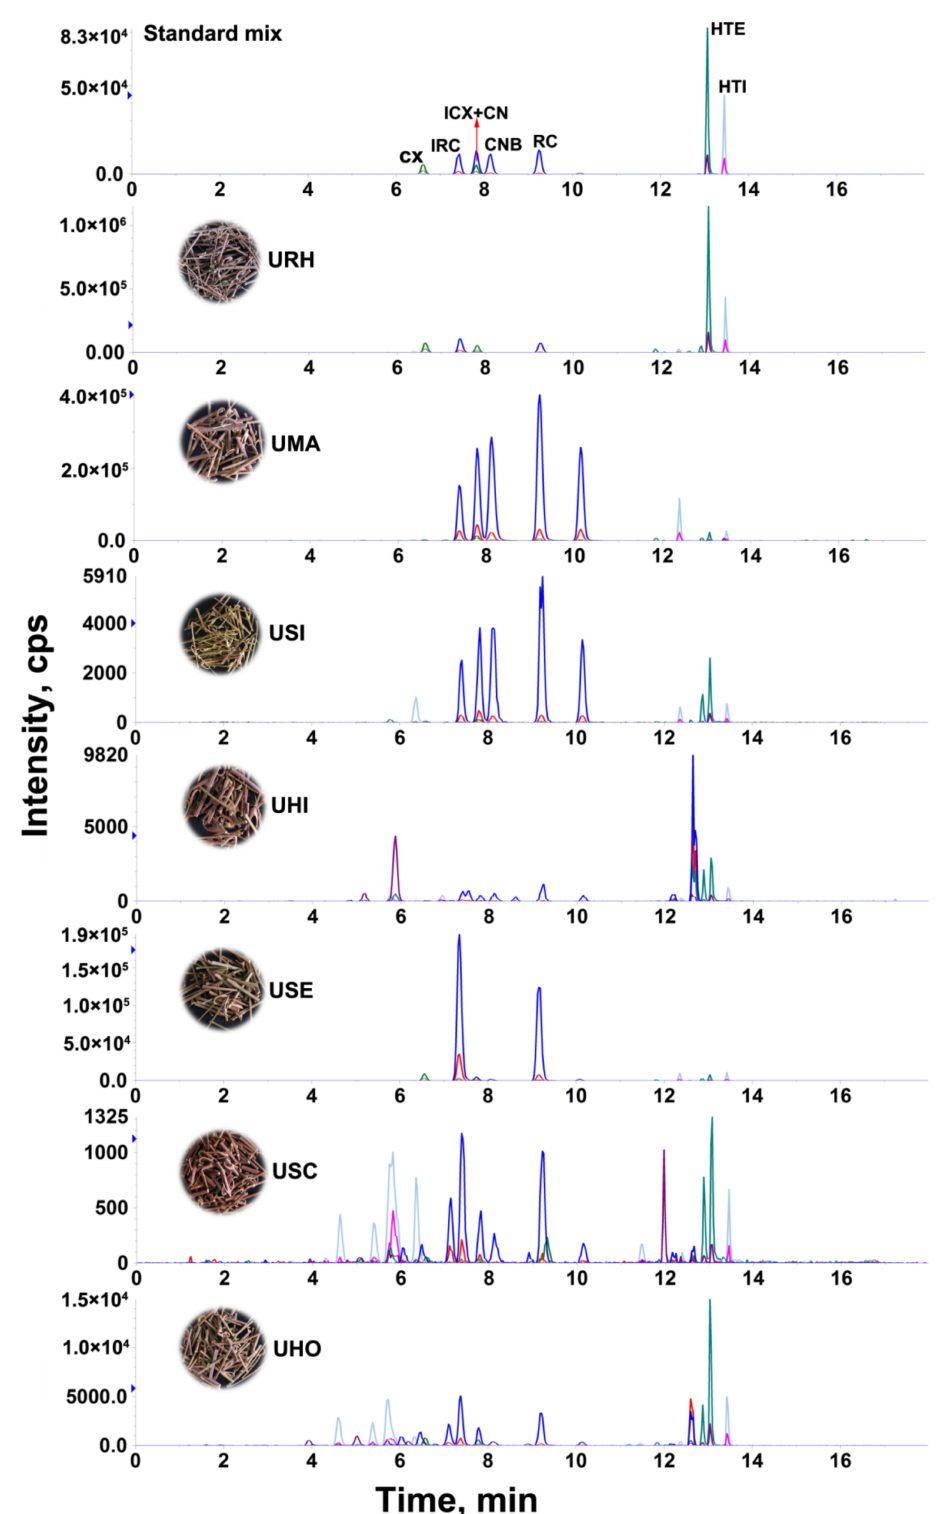
Figure 2. The MRM chromatograms of standard mixture and representative Uncaria samples. Hierarchical clustering analysis (HCA), a chemical pattern recognition and classification evaluation method, was used to assess the resemblance and differences of 24 Uncaria samples. HCA was carried out based on the contents of targeted alkaloids using a software of HemI (Heatmap Illustrator, version